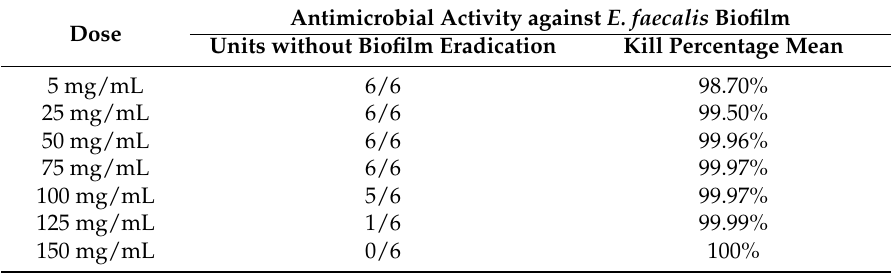
Table 3. Antimicrobial activity of geranium essential oil against E. faecalis biofilm in dentin. Antimicrobial Activity against E. faecalis Dose